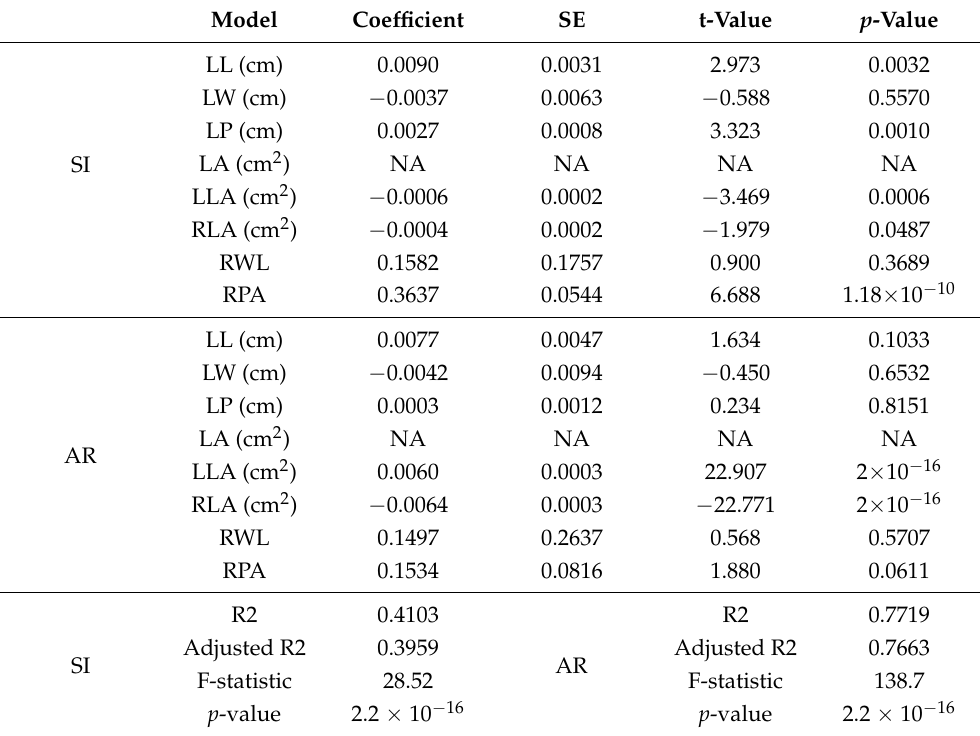
Figure 5. The LSD of the natural logarithm of AR ( a ) and SI ( b ) for measuring leaf bilateral symmetry. a, b, c represent the significance of the difference. Table 1. Multivariate linear model prediction between leaf fluctuating asymmetry and leaf pheno- typic traits.